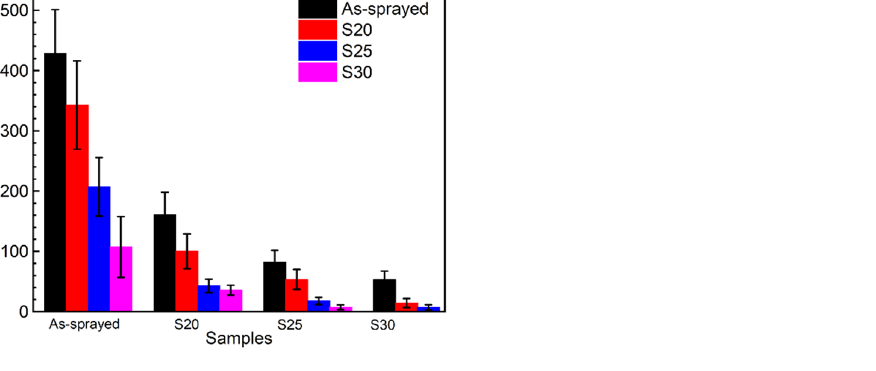
Figure 3. Size distribution of interfacial pores for the as-sprayed, S20, S25, and S30 samples. S20, S25, and S30 indicate the as-sprayed NiCrBSi coatings remelted at 20 kW, 25 kW, and 30 kW.